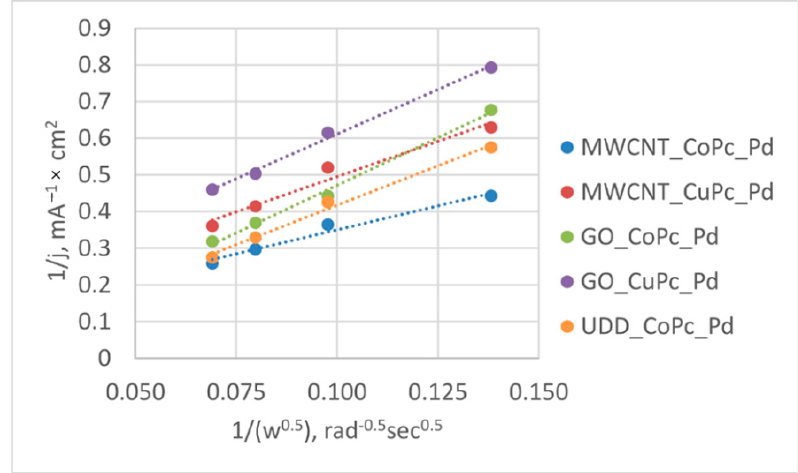
Figure 8. Dependences in the coordinates of the Koutecky–Levich equation at the potential − 0.8 V for all catalyst samples.